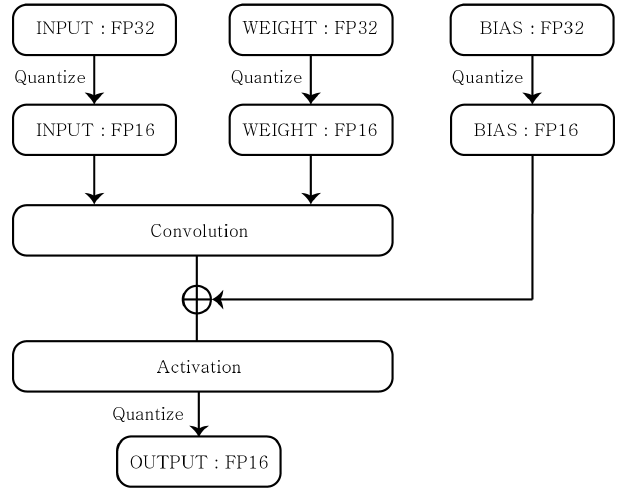
Figure 5. Float 16